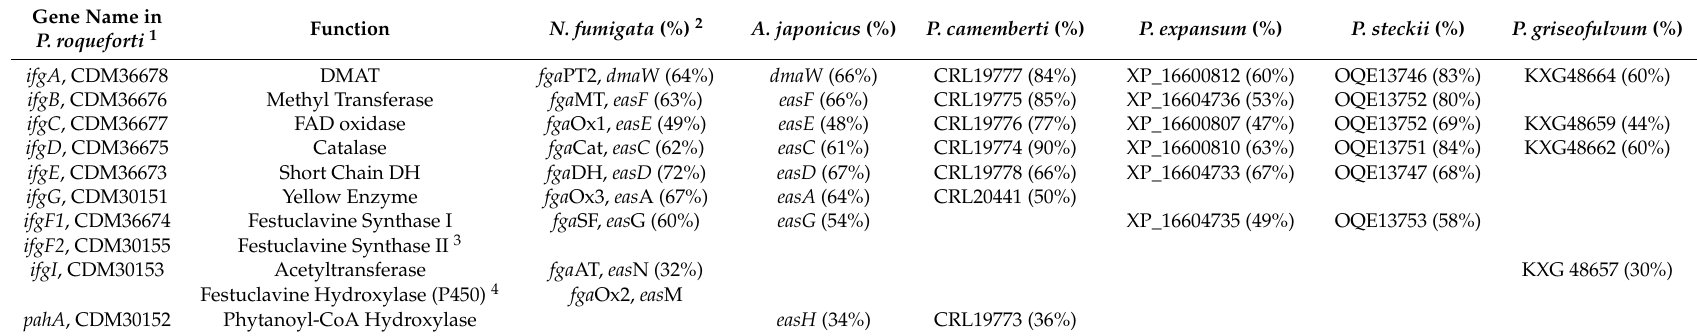
Function of the ifg genes, located in the isofumigaclavin gene cluster of Penicillium roqueforti . Comparison of the encoded proteins with orthologous/homologous proteins in other clavine